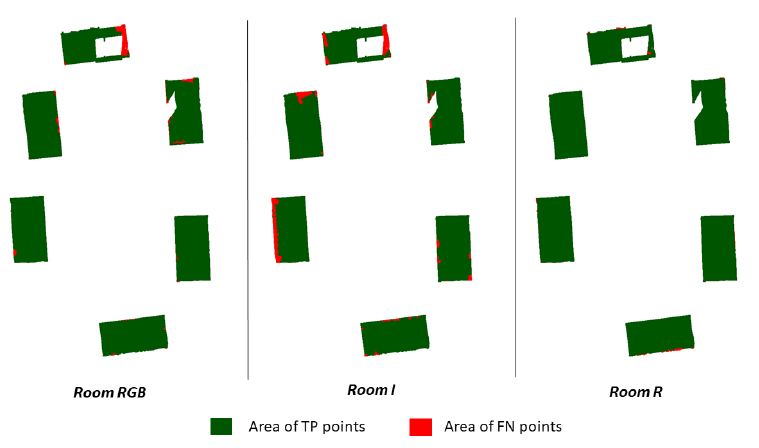
Figure 13. TP and FN areas of dataset Room at different semantic segmentations for the table class. The analysis of the areas can also be useful, if the inverse RA, the area of FN points, is considered. This indicates which areas are not assigned to the correct class. These are holes or missing parts in the segmented point cloud. By visualizing these areas, it is possible to identify certain problematic sections for which the applied tools do not allow correct class assignment. The problematic sections are colored red in Figure